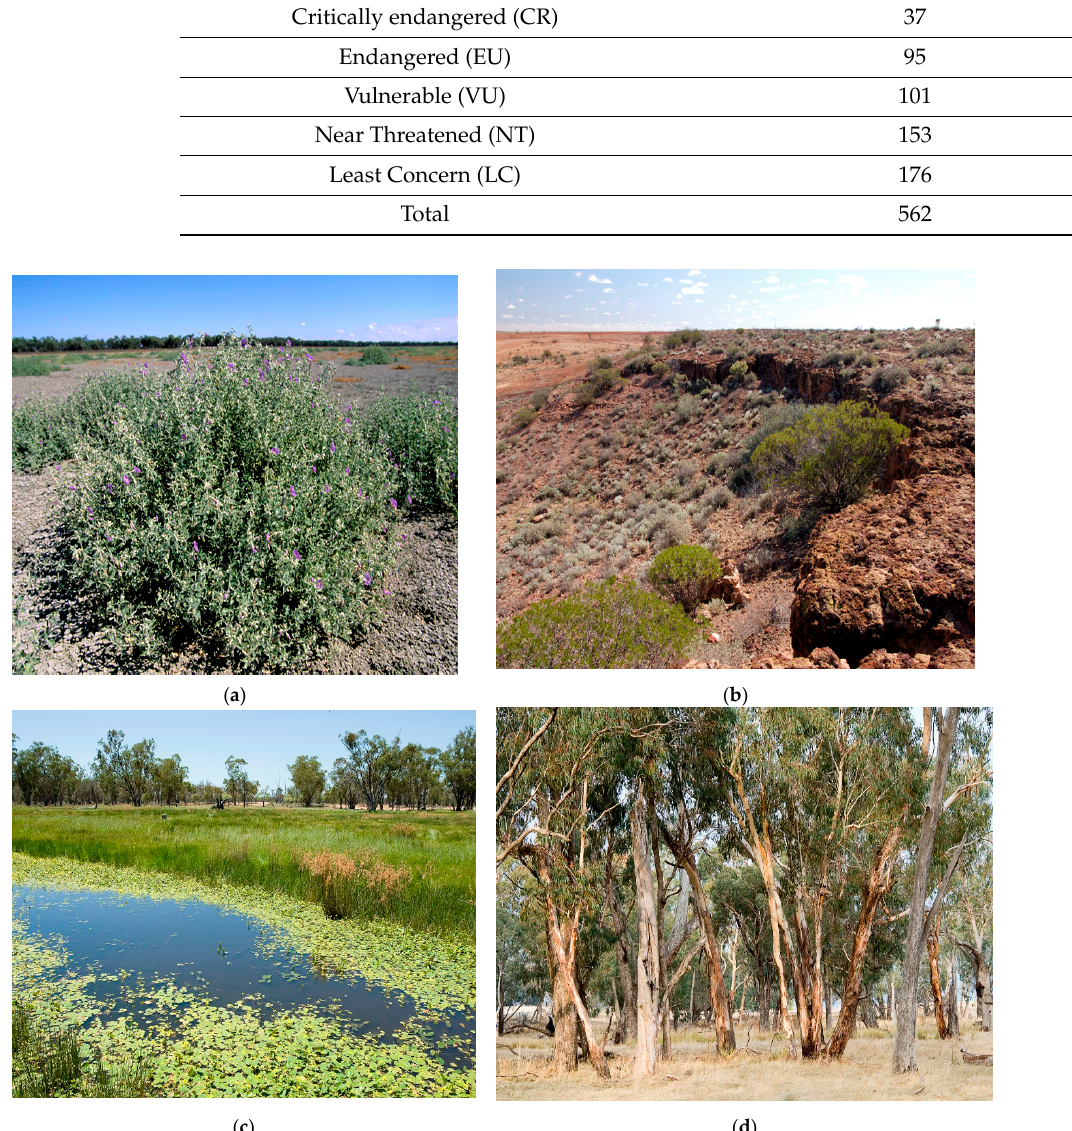
Figure 3. Four distinct inland NSW PCTs defined qualitatively with limited plot samples. These PCTs could be overlooked in vegetation classification generated solely though analyses of available plot data: ( a ) PCT 189 Lakebed cracking clay ephemeral forbland in the arid zone, threatened by lakebed cropping, Near Threatened. ( b ) PCT 132 Silcrete scarp shrubland in Sturt National Park in the arid zone, grazing by feral and native animals limiting regeneration of some species, Least Concern. ( c ) PCT 364 Sodic soils wetland in the Yetman-Yelarbon region, Brigalow Belt South Bioregion, Near Threatened. ( d ) PCT 304 Candlebark ( Eucalyptus rubida )-Apple Box ( Eucalyptus bridgesiana) open forest on granite, upper NNS bioregion, part of a listed NSW TEC, Critically Endangered.